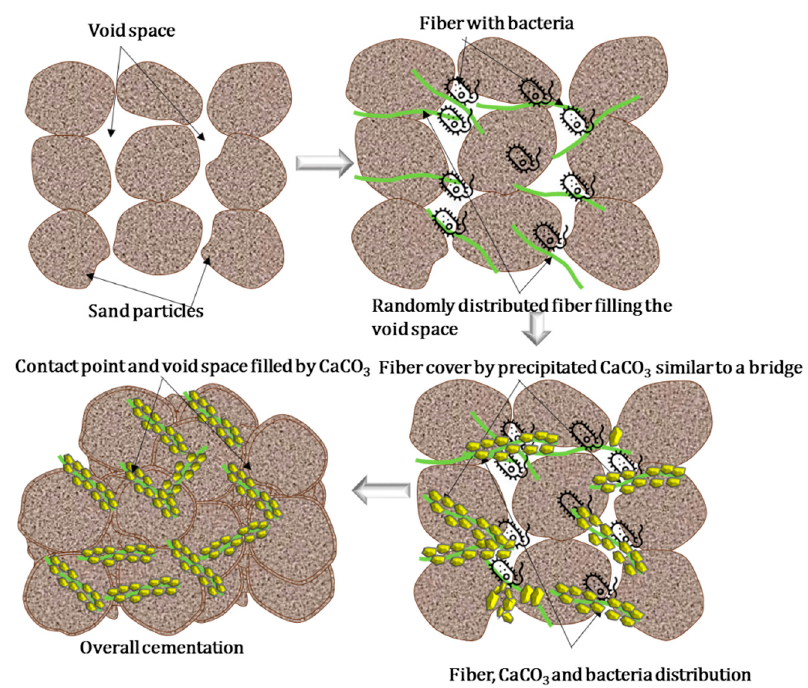
Figure 18. Schematic diagram of biocemented sample with the addition of jute fibers. Table 6. Summary of test results for the biocemented sand after MICP treatment with jute fibers.